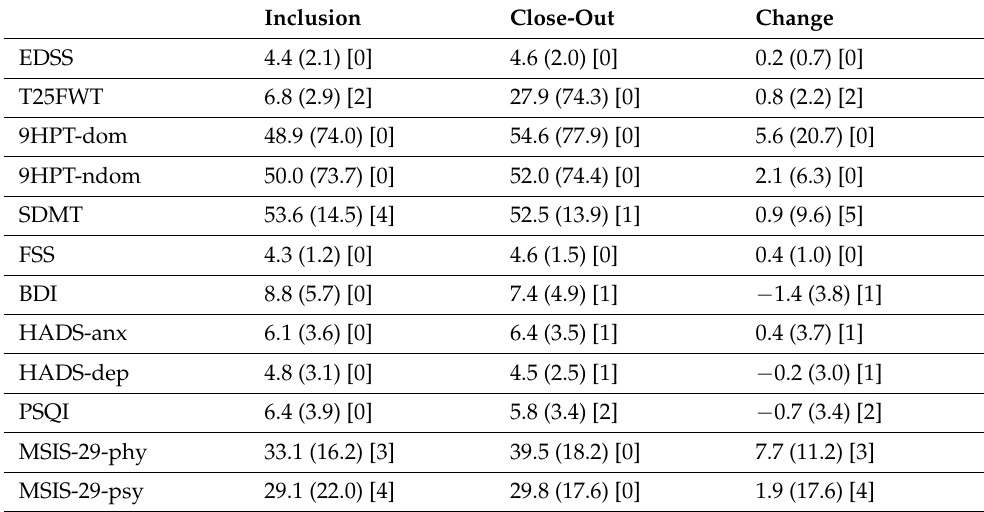
Table 3. Functional outcomes in patients randomized to the control group who completed the study ( N = 26)